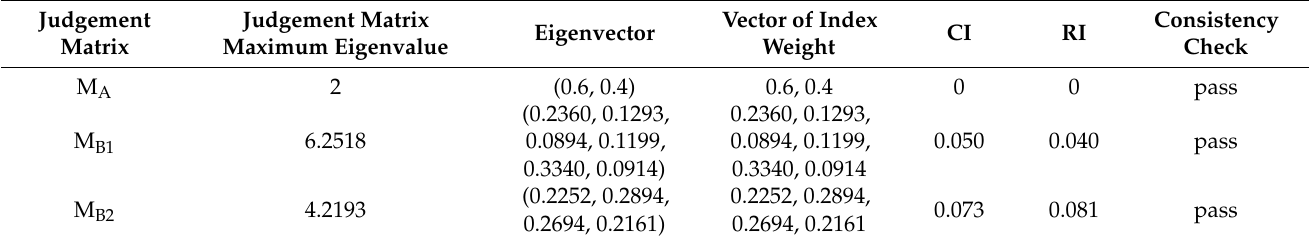
Table 3. Judgement matrix eigenvectors, index weights and consistency test.